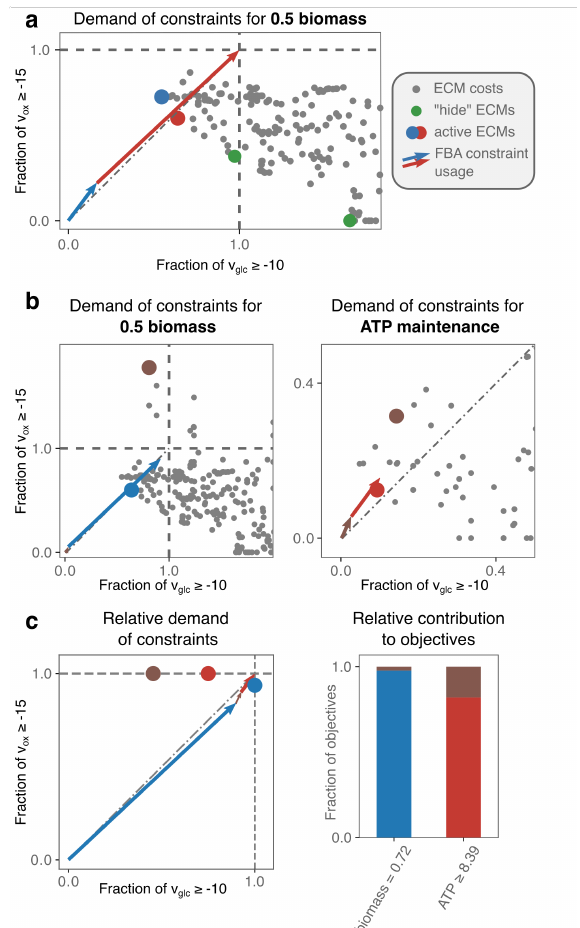
Figure 2. A core model of Escherichia coli is used to introduce our analysis of FBA solutions. We analyze the FBA solutions of the e_coli_core -model [31] with a constraint on glucose- and oxygen- uptake in ( a ), and add an ATP-maintenance demand in ( b , c ). In ( a ), for each of the 689 ECMs, each dot represents the fraction of the constraints that the ECM takes up when it produces biomass at a rate of 0.5. We scale to 0.5 for visualization only; it does not change the analysis. The green dots represent the costs of the ECMs that are obtained using the hide -method of ecmtool . We explain in the main text (and in [22]) that these “hide”-ECMs are extreme with respect to the chosen constraints, and can therefore always form the optimal solution. The vectors show that the red and blue EMs constitute the FBA solution. This could have been found by the visual optimization procedure as well: when all pairs of cost dots are connected by a line, the line connecting the blue and red dot intersect the diagonal closest to the origin (see text and Figure A1 for an explanation). ( b ) An ATP-maintenance demand can be imposed as a constraint, but it is better to view it as setting a secondary objective: the demanded ATP should be produced as efficiently as possible. We therefore make an additional plot that indicates the costs of the EMs for meeting this demand. Not all EMs appear in both plots, e.g., an EM that does not produce ATP will not appear in the right plot because it has ‘infinite costs’. The selection of the optimal EMs can now be understood: the red EM produces ATP most efficiently; the rest of the available glucose- and oxygen-supply can be used by the blue EM to produce biomass. However, the red and blue EM cannot exactly use all of the supply: the remainder is used by the seemingly inefficient brown EM that produces both biomass and ATP. ( c ) With more than two constraints or secondary objectives, an alternative visualization will be better suited. We only visualize optimal EMs; their dots still indicate the relative usage of the constraints, but are no longer normalized with respect to an objective. The vectors show which EM uses which fractions of the constraints. In turn, the bar plot indicates which EM contributes to which